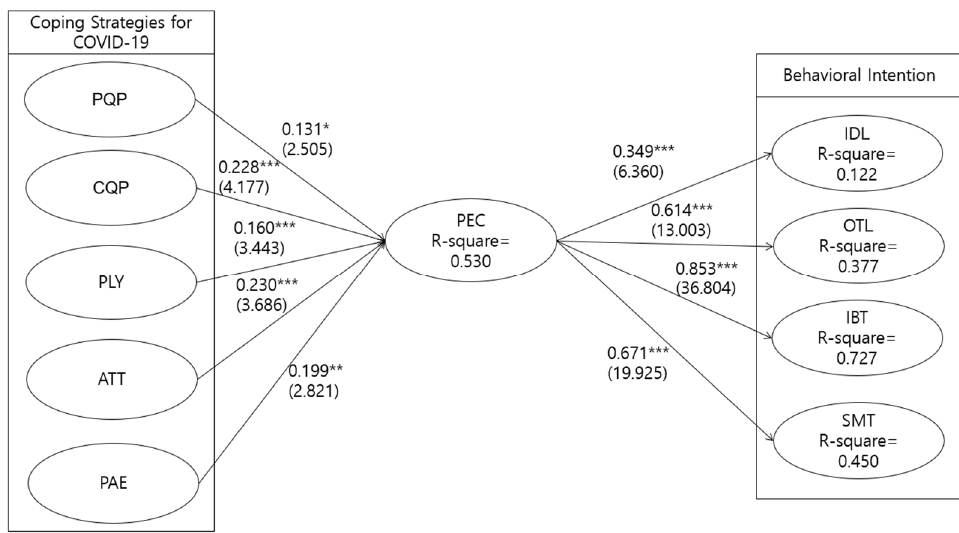
Figure 2. Structural model results. Note 1: * p < 0.05, ** p < 0.01, and *** p < 0.001. Note 2: Values not in parentheses are standardized parameter estimates; values in parentheses are t values. Note 3: ATT = Attitude; PAE = Positive Anticipated Emotion; PLY = Policy; PEC = Positive Expectation of